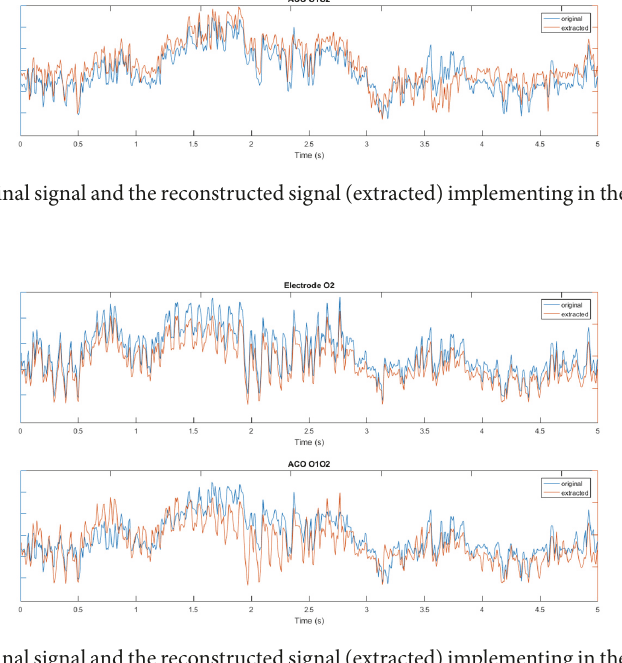
Figure 27: Comparison of the original signal and the reconstructed signal (extracted) implementing in the ACO model the mixture of signals O2 and